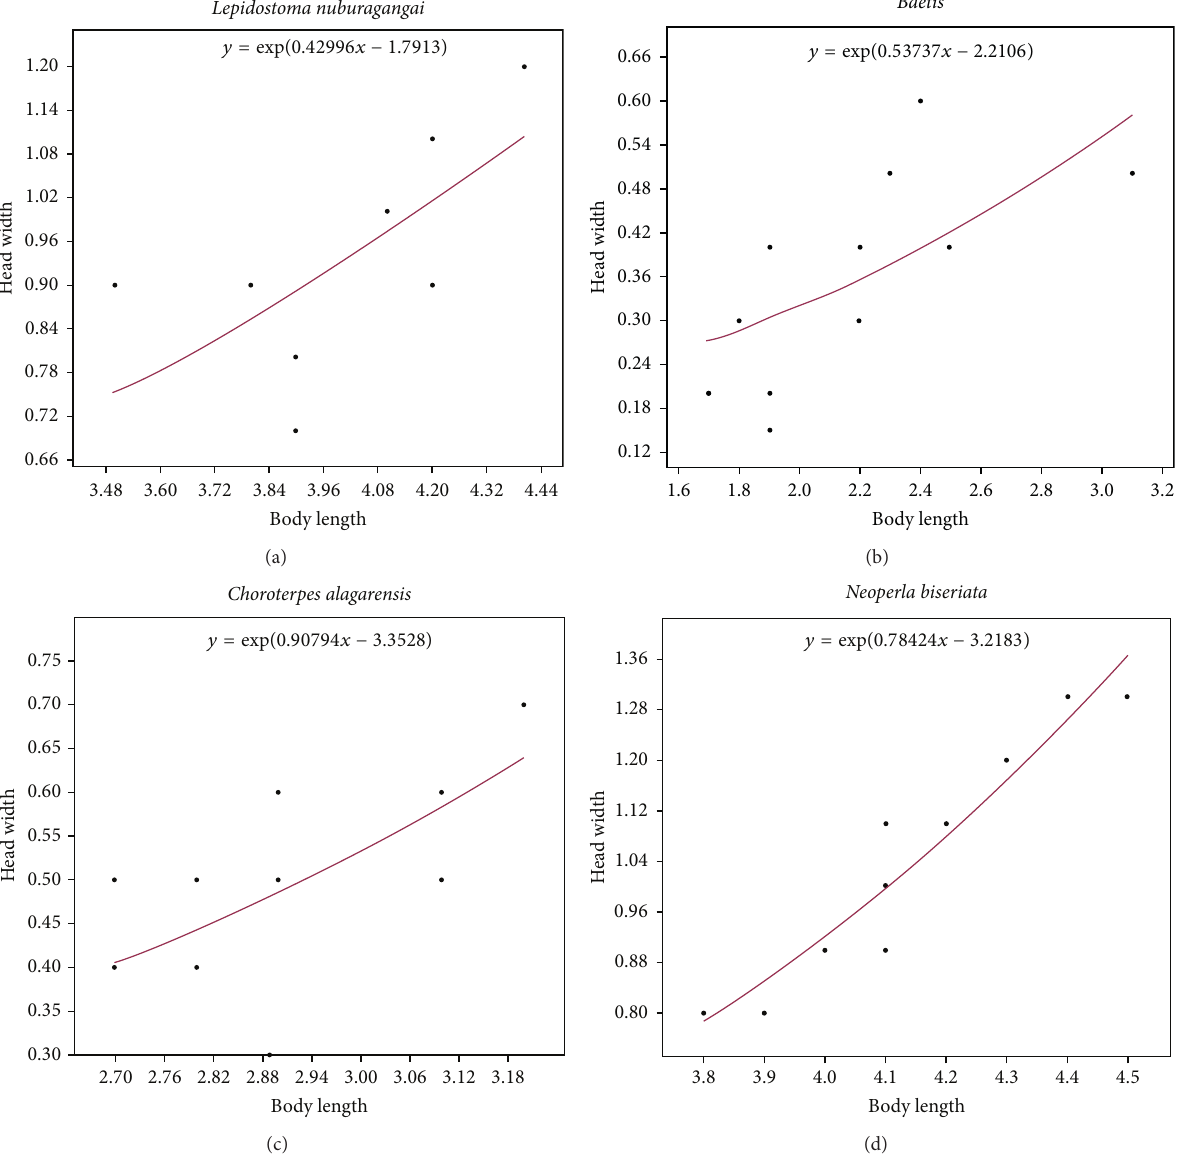
Figure 6: Linear regression model for head width and body length of four functional taxa.